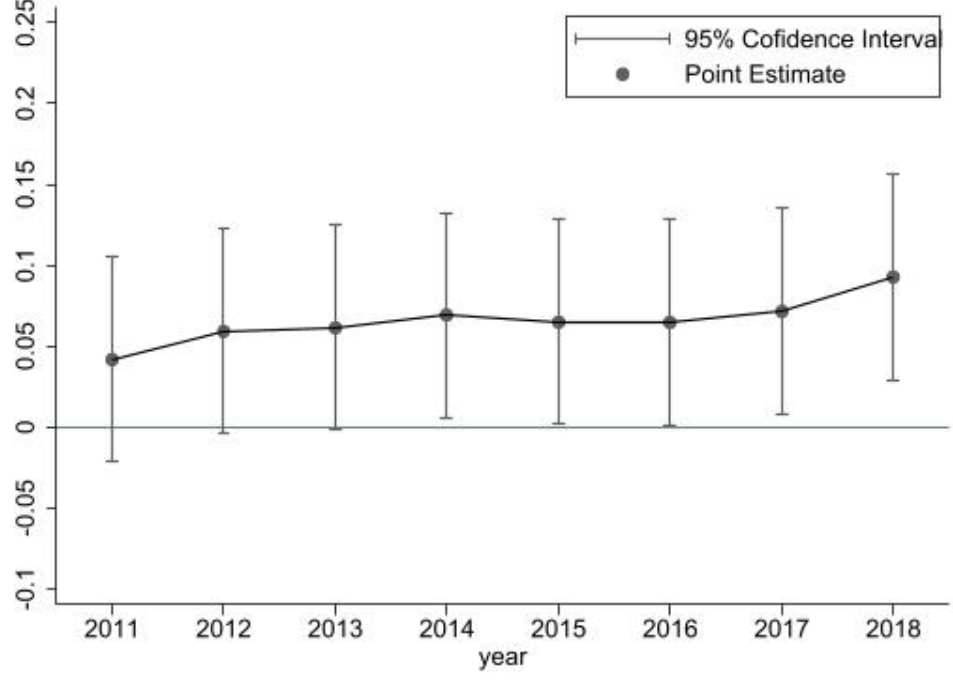
Figure 1. Results of the parallel trend test.